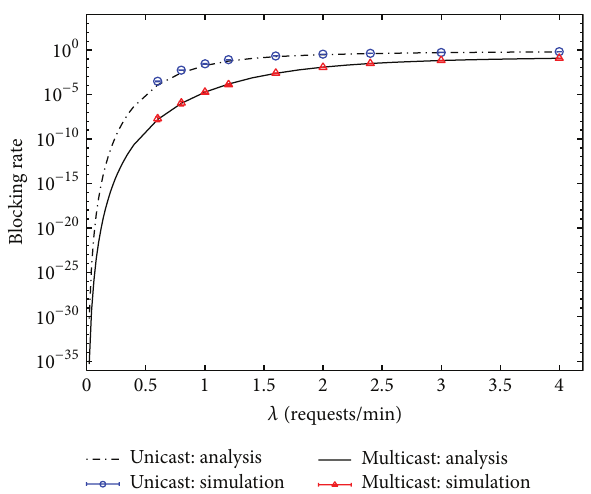
Figure 8: Blocking rates of unicast and multicast IPTV services under the scenario of heterogeneous service rates. (Hit rate distri- bution: uniform.)